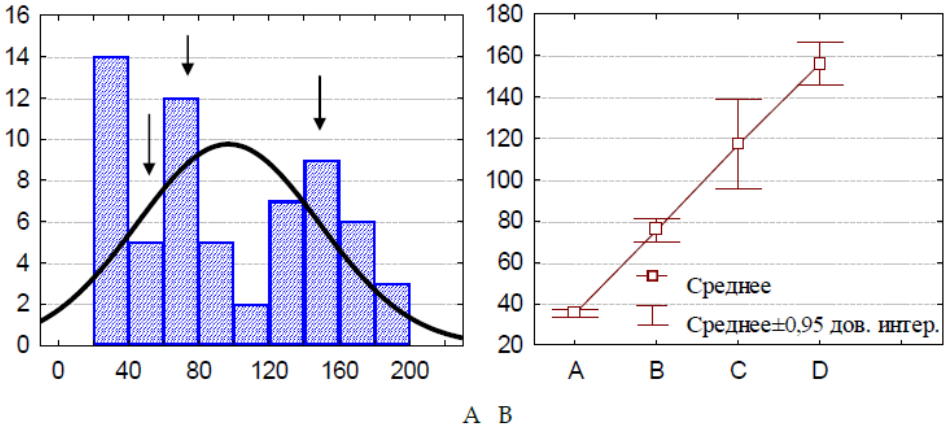
Рис. 2. Гистограмма распределения численности (А) и категоризация